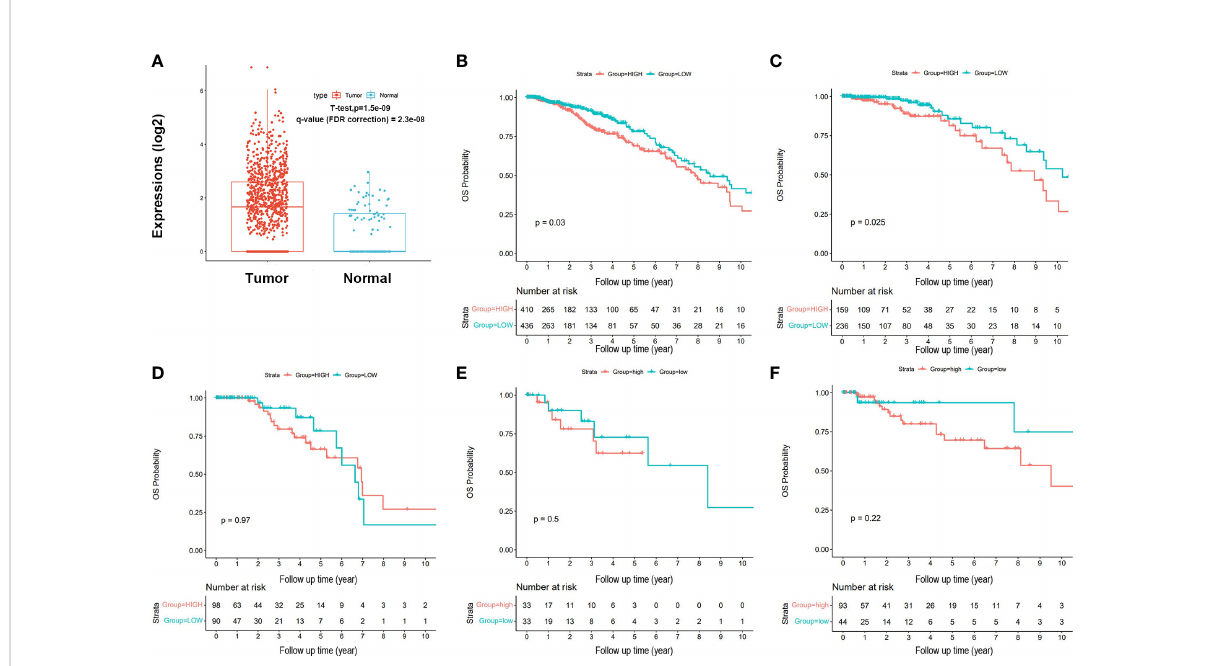
FIGURE 1 Expression and survival of SNORA38 signature in breast cancer. (A) SNORA38 expressed higher in breast cancer tissues than in normal tissues in TCGA ( P < 0.05). (B) High SNORA38 expression was relevant to a shorter OS in all BC patients in Kaplan – Meier plotter ( P = 0.030). (C) High SNORA38 expression was relevant to a shorter OS in luminal A patients in Kaplan – Meier plotter ( P = 0.025). (D) High SNORA38 expression did not show any association with a shorter OS in luminal B patients in Kaplan – Meier plotter ( P = 0.973). (E) High SNORA38 expression did not show any association with a shorter OS in Her-2 type patients in Kaplan – Meier plotter ( P = 0.501). (F) High SNORA38 expression did not show any association with a shorter OS in basal-like type patients in Kaplan – Meier plotter ( P =